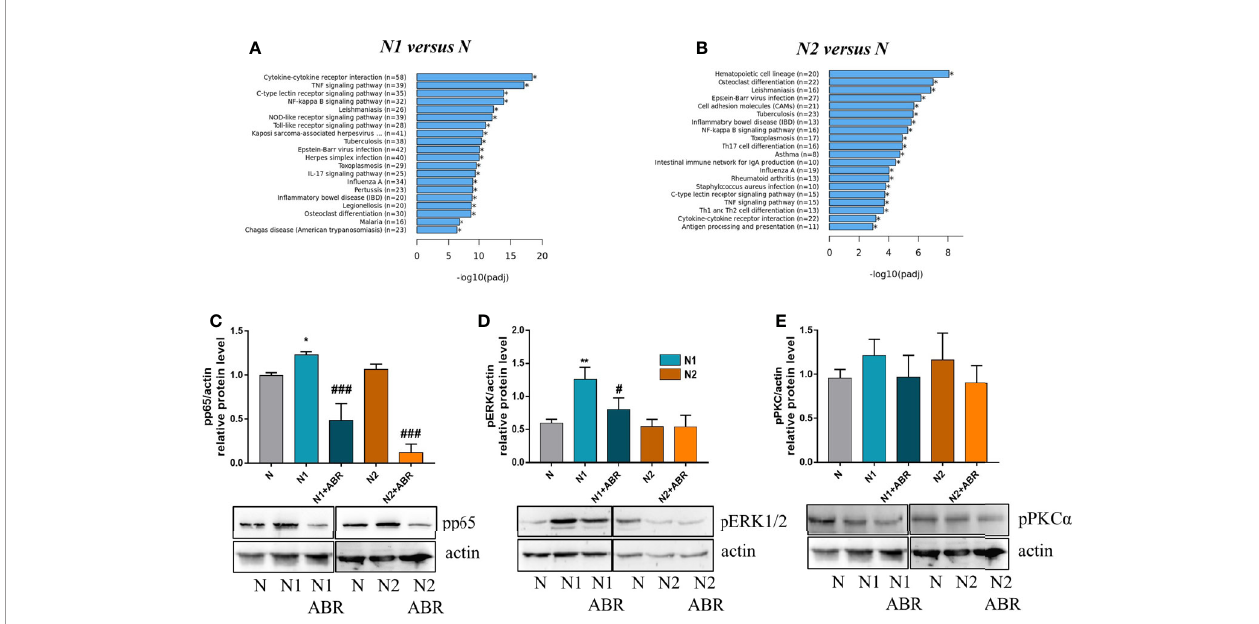
FIGURE 7 | Signaling pathways activated in neutrophils subtypes. (A, B) The top 20 signaling pathways revealed by the KEGG signaling pathway enrichment analysis in N1 and N2 compared with control neutrophils (N). (C-E) Analysis of the phosphorylation form of p65, ERK and PKC in neutrophil subsets. Cell lysate from control (N), or polarized neutrophils (N1 and N2) cultured for 18h in the presence or absence of ABR-238901 (ABR) was analyzed by Western blot; n = 3, *p < 0.05, **p < 0.01 (N1 vs N), # p < 0.05, ### p < 0.001 (N1 vs N1 +